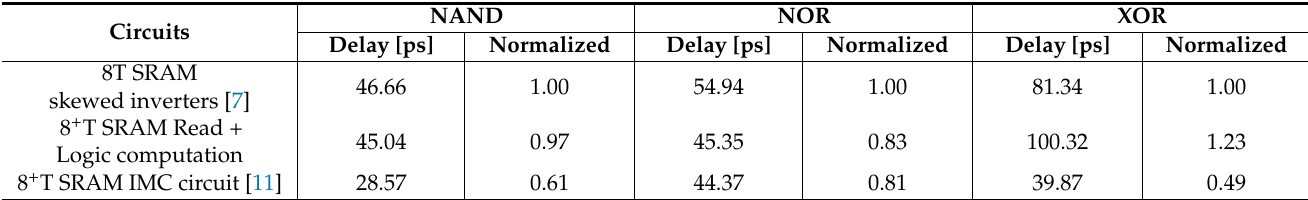
Table 1. Comparison of logic computation delay in different circuits.